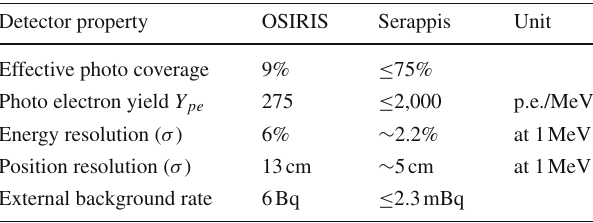
Fig. 1 Layout of the OSIRIS setup Table 1 Expected performance parameters of the upcoming OSIRIS and the upgraded Serappis detector